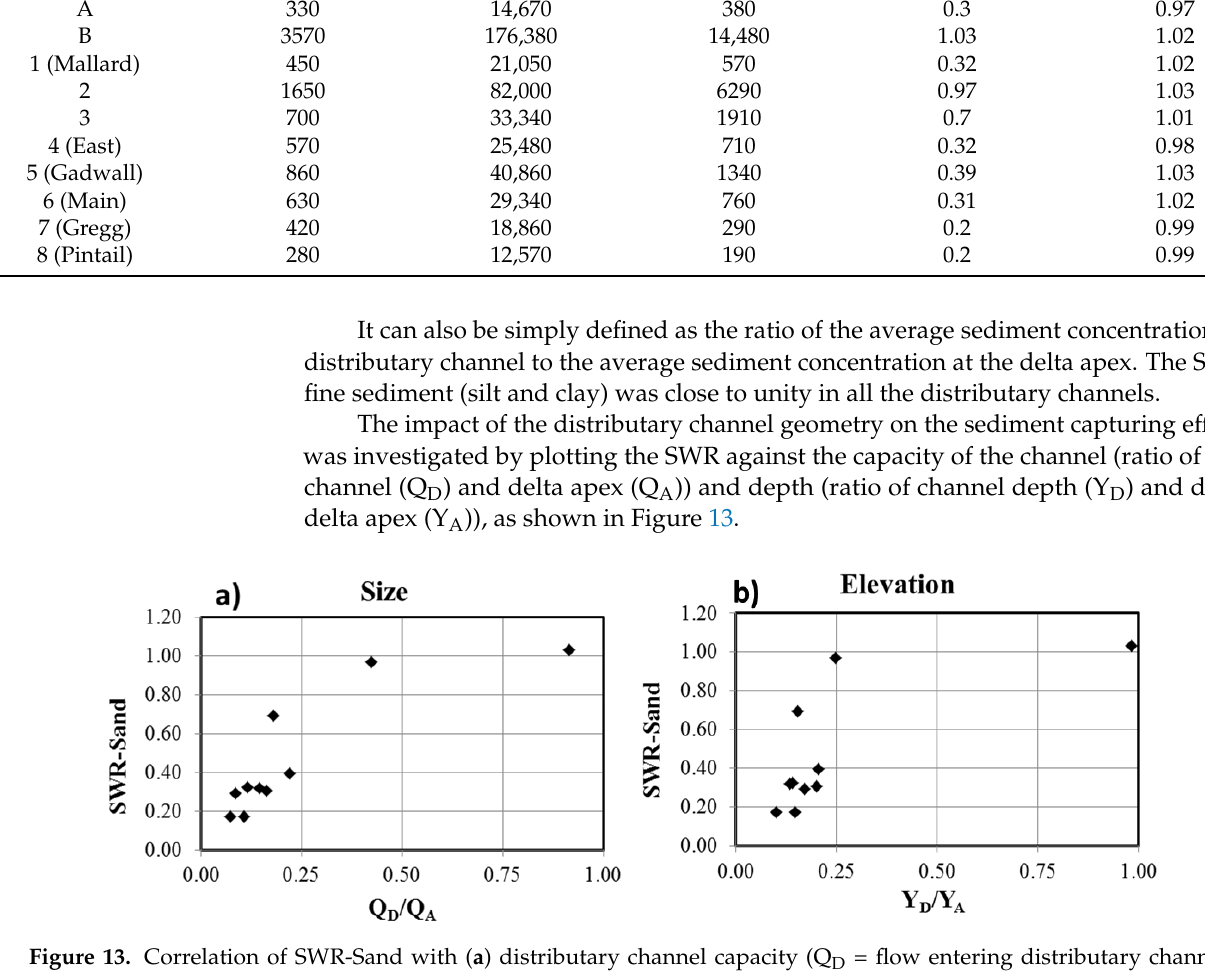
Table 2. Flow and sediment distribution in the WLD channels during river flood.